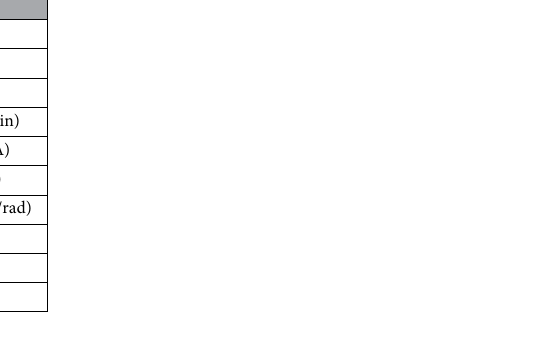
Table 1. Basic parameters of